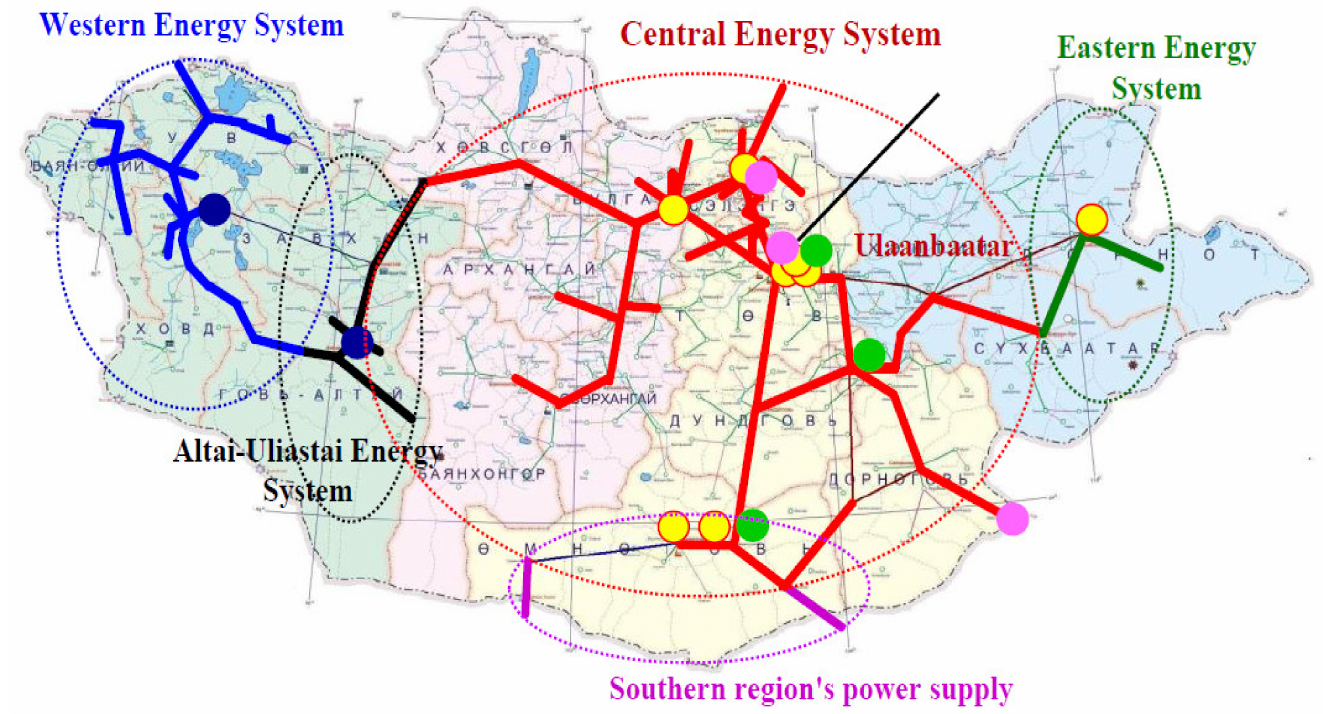
Figure 6. Geographical map showing the location of the energy systems in